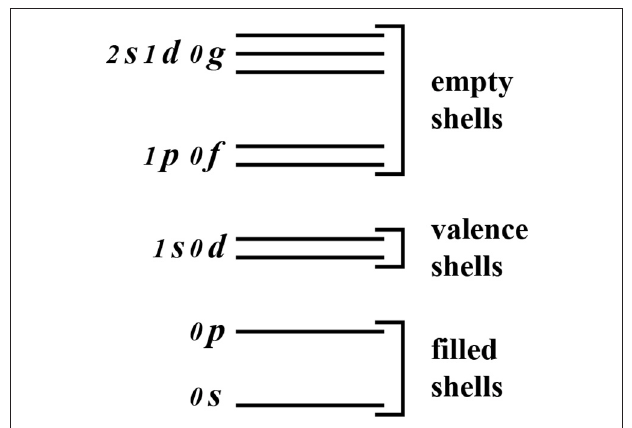
FIGURE 1 | Energy shells that characterize the core, valence space, and empty orbitals for 18